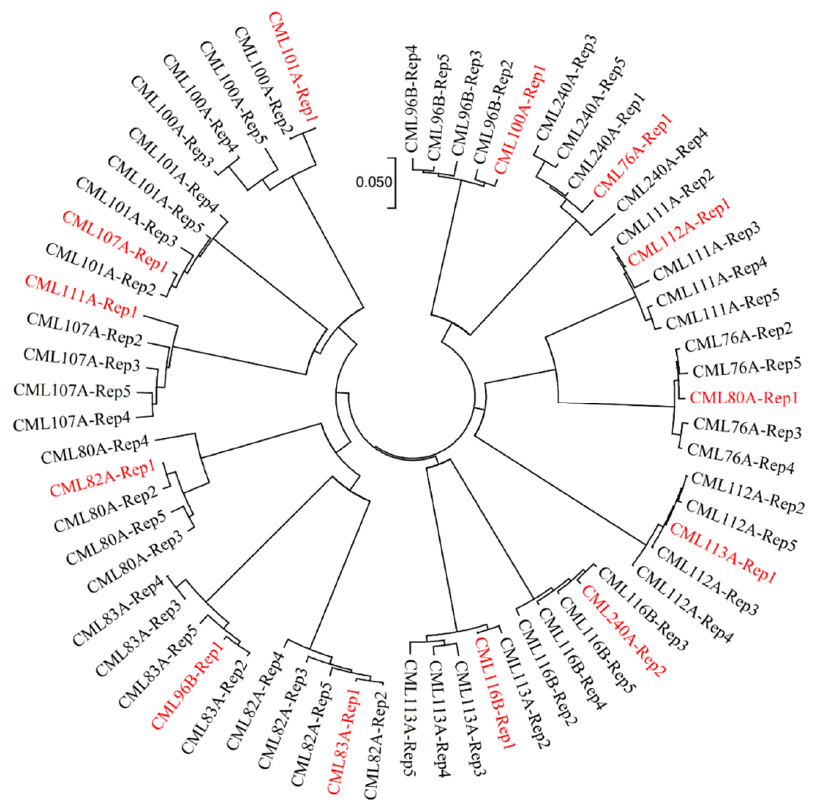
Figure 4. Neighbor-joining tree for the thirteen mislabeled CMLs in the first round of genotyping, estimated with the fingerprinting SNP dataset of five biological duplications from both rounds of genotyping. Rep1 and Rep2 represent the two biological duplications from the first round of genotyping, and Rep3, Rep4, and Rep5 represent the three biological duplications from the second round of genotyping. Mislabeled biological duplications were indicated in red